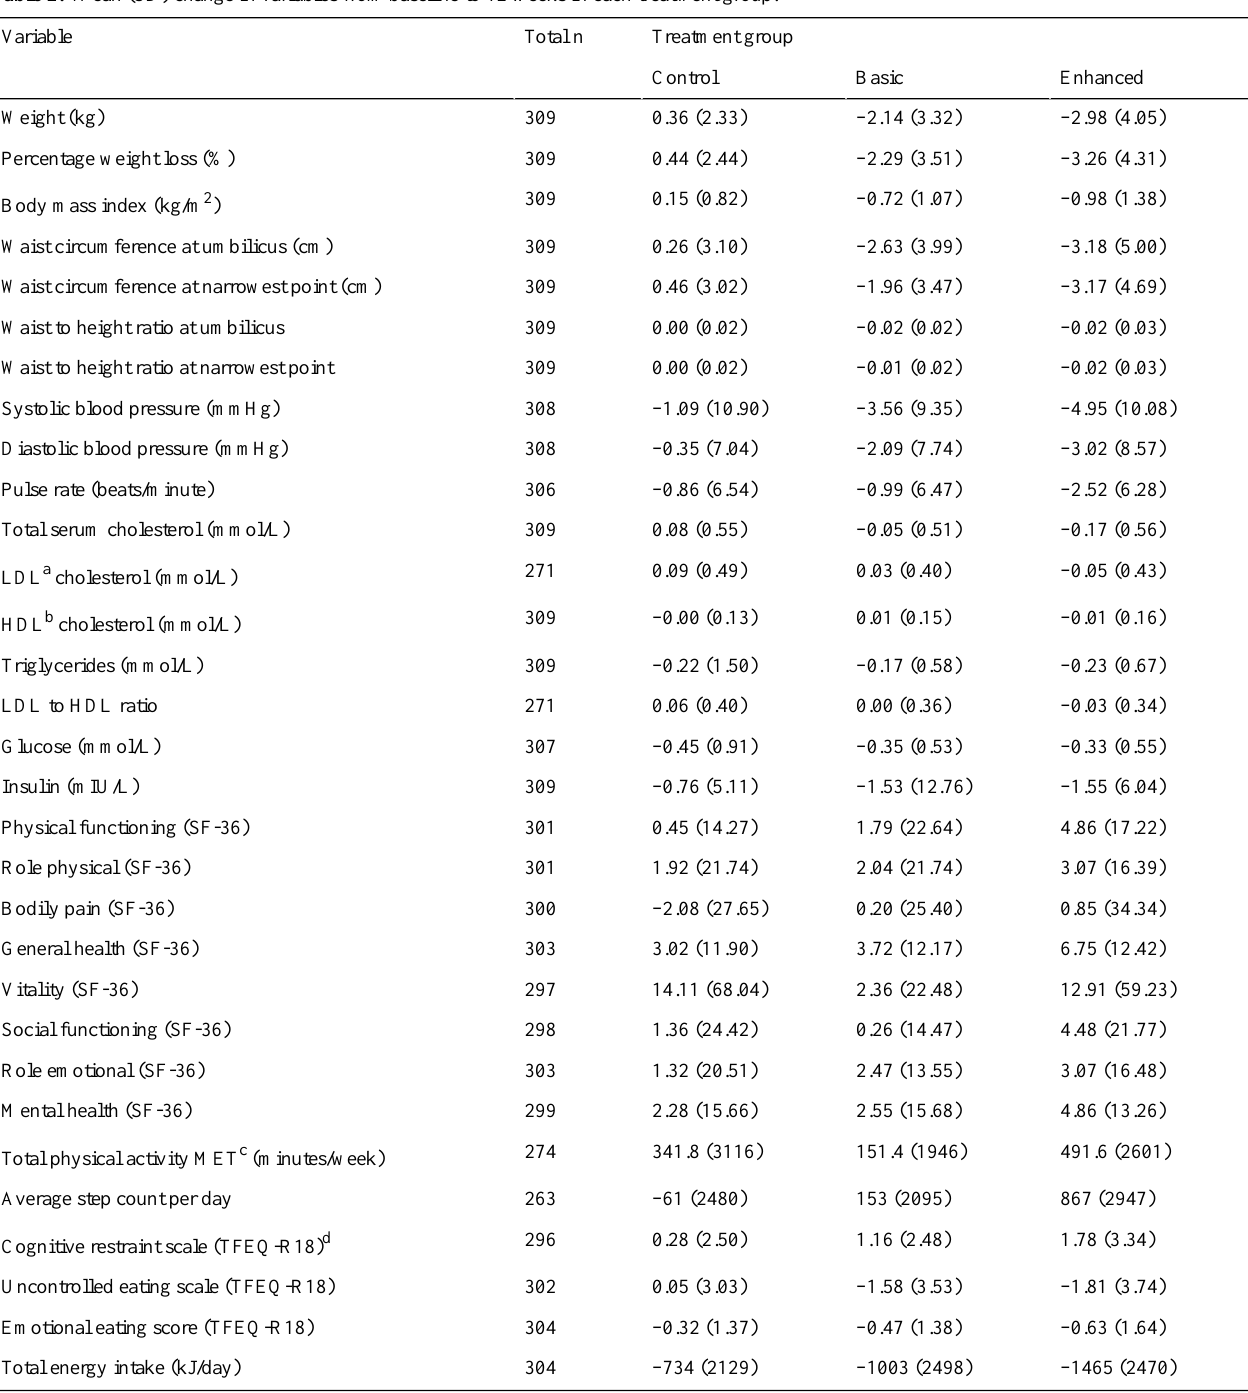
Table 2. Mean (SD) change in variables from baseline to 12 weeks in each treatment